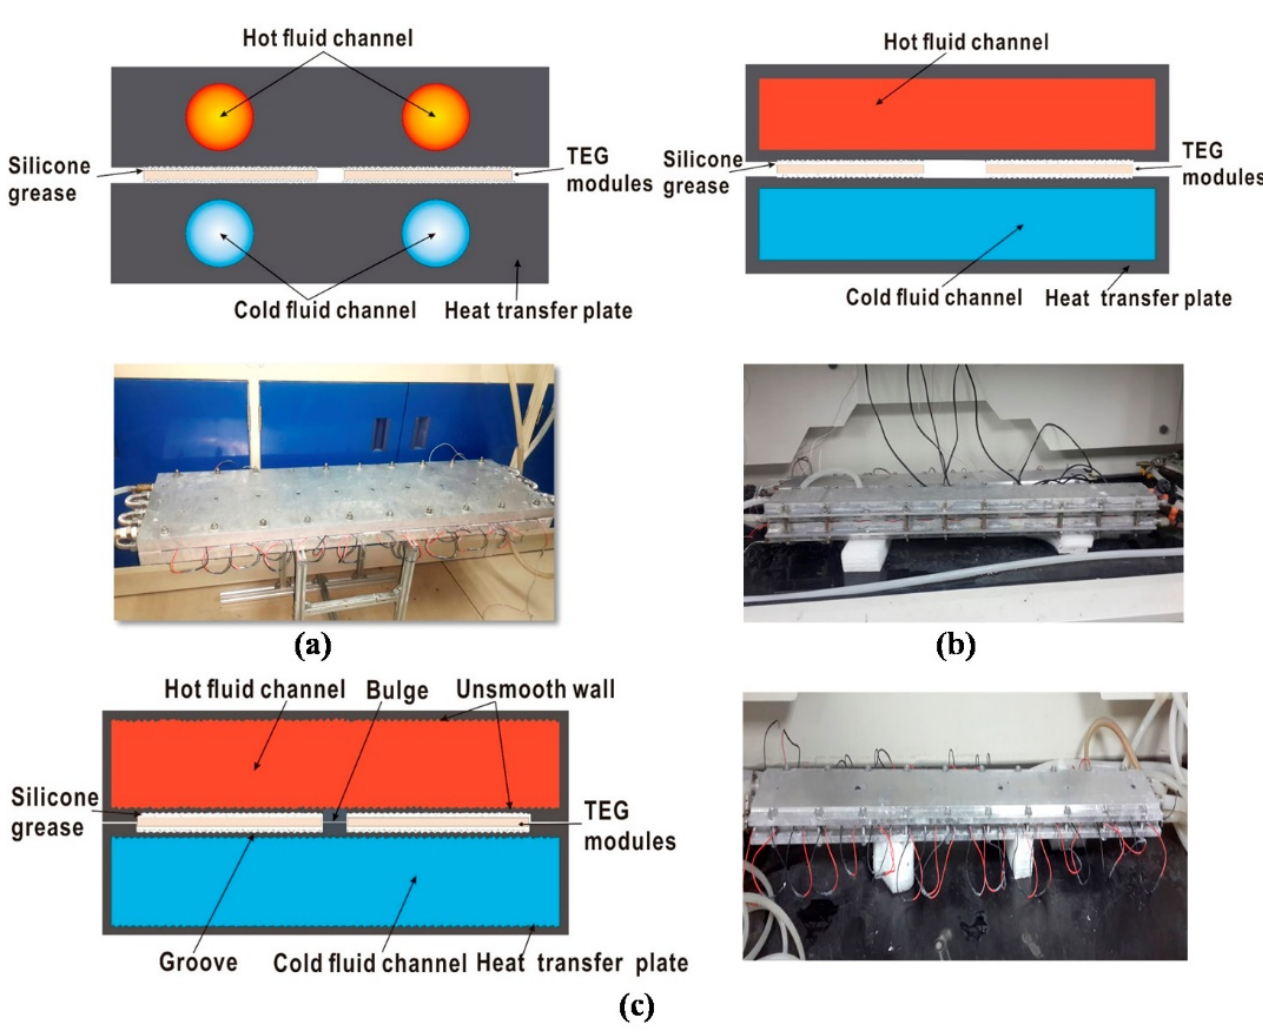
Figure 3. Different fluid heat exchanger: ( a ) Block with two tubes; ( b ) A single channel stripe; ( c ) A single channel stripe with a lower height and with rougher inner surface [51].